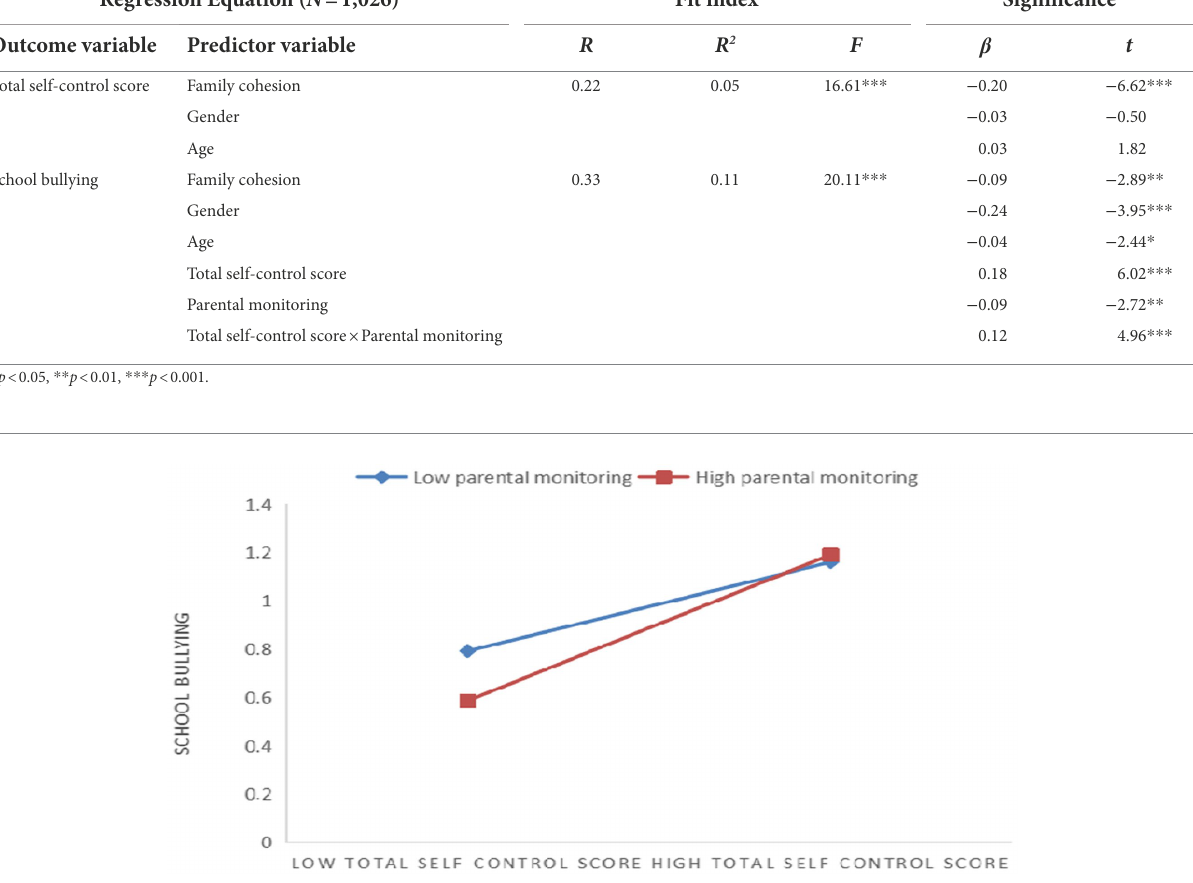
TABLE 4 Test of the moderated mediating model.